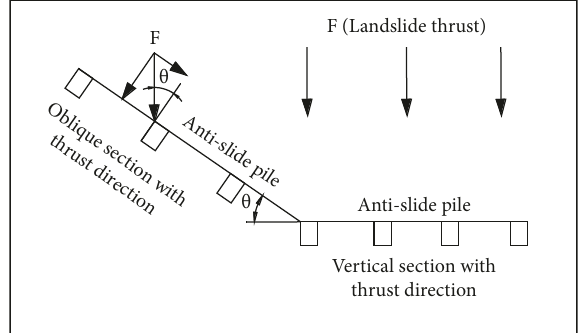
Figure 1: Schematic of polyline pile arrangement (made by the